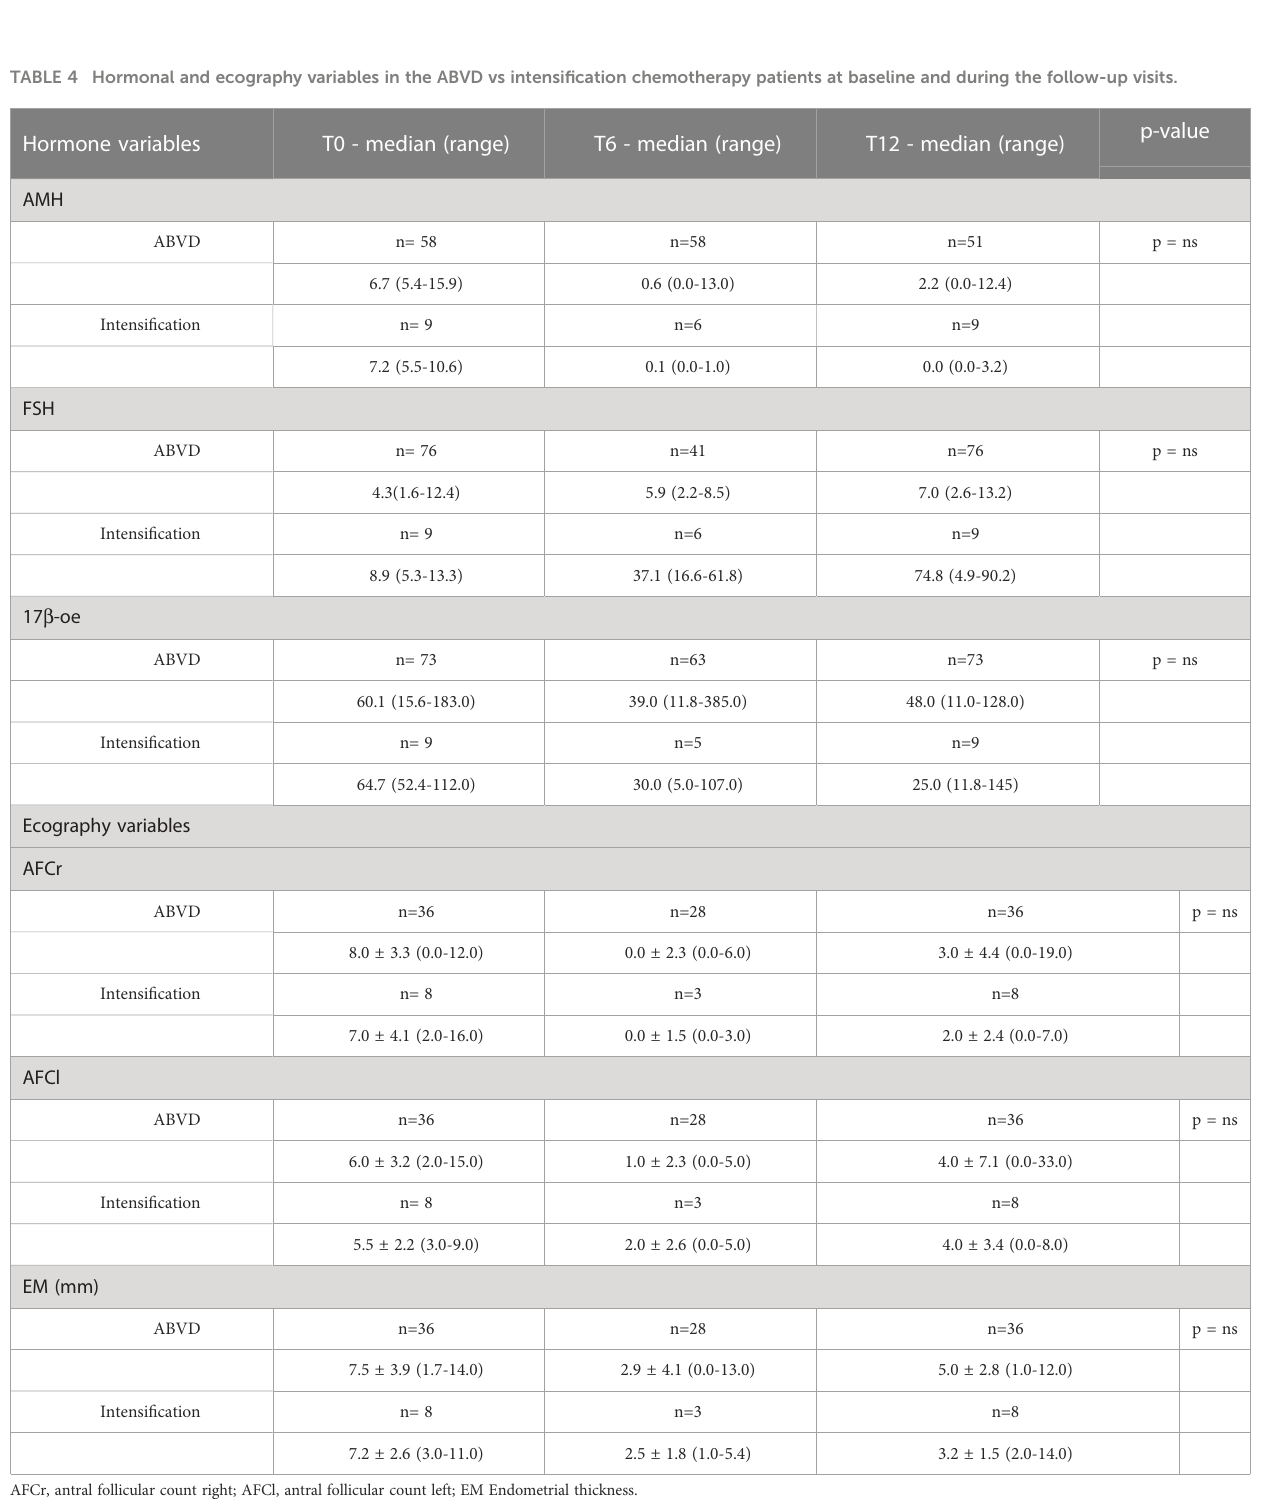
TABLE 4 Hormonal and ecography variables in the ABVD vs intensi fi cation chemotherapy patients at baseline and during the follow ‐ up visits.